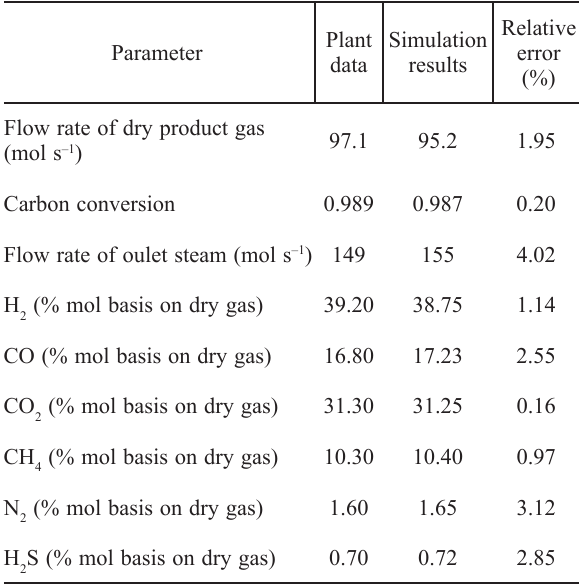
Table 4 – Comparison between simulation and plant data for Pittsburgh No. 8 coal Parameter